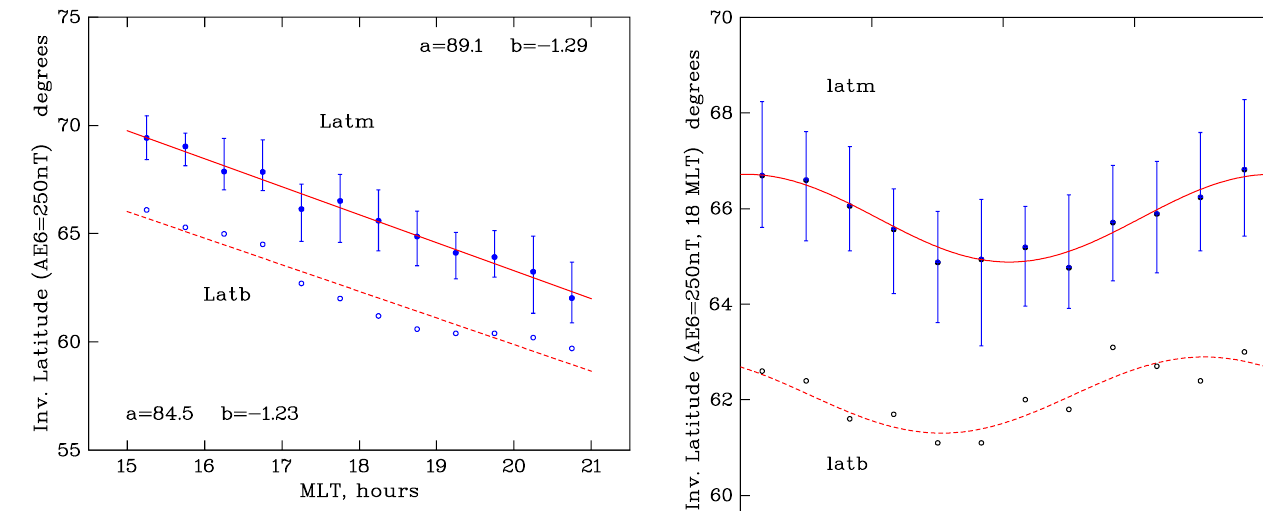
Fig. 4. Position of the equatorward trough wall as a function of magnetic local time. The format of data presentation corresponds to that of Fig. 3 except that the magnetic activity index is replaced by the magnetic local time (MLT). Note that the results presented in this figure refer to a geomagnetic activity level of AE 6=250nT.